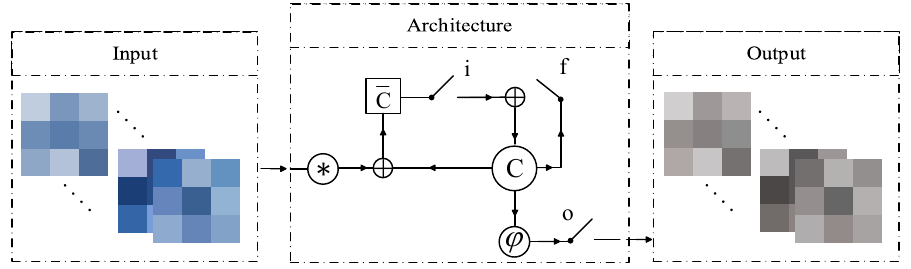
Figure 3. The input, architecture, and output of the convolutional long short-term memory